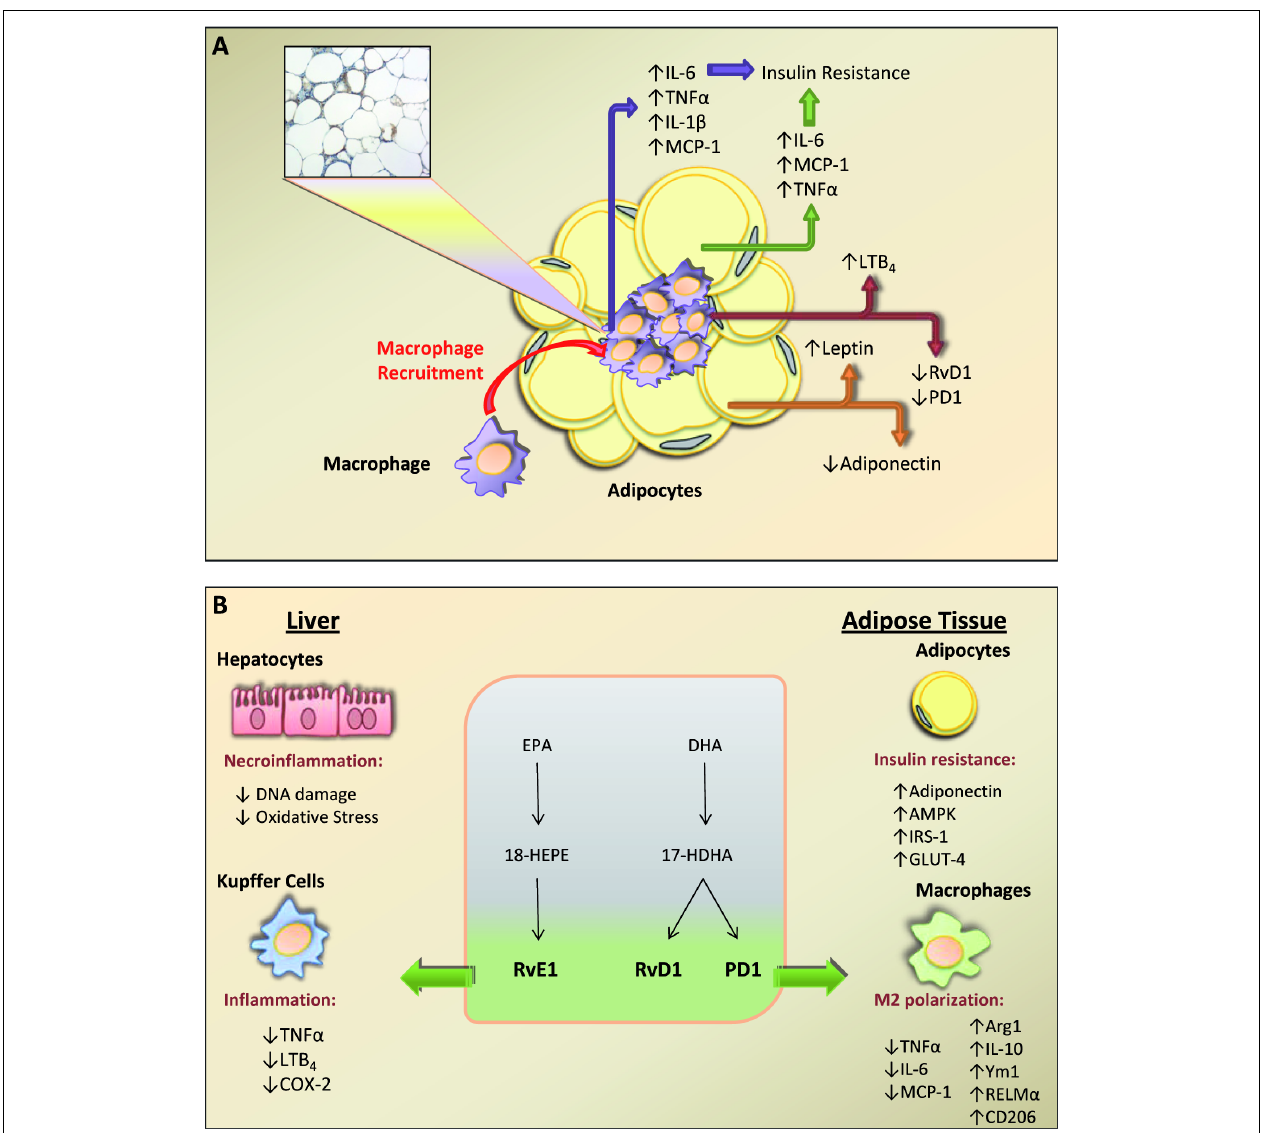
FIGURE 2 | (A) Schematic overview summarizing the cross-talk between macrophages and adipocytes in obese adipose tissue. Obese adipose tissue shows a remarkable infiltration of macrophages which form “crown-like” structures that surround necrotic adipocytes.This recruited macrophages together with hypertrophy and/or hyperplasia of adipocytes produce an aberrant release of pro-inflammatory adipokines [tumor necrosis factor (TNF) α , interleukin (IL)-6, IL-1 β , and monocyte chemotactic protein-1 (MCP-1)] that leads to insulin resistance. Unbalanced formation of pro-inflammatory leukotriene (LT) B 4 and leptin accompanied by a deficit in anti-inflammatory mediators [i.e., resolvin (Rv) D1, protectin (PD) 1, and adiponectin] contributes to a state of unresolved inflammation in obese adipose tissue. (B) Schematic representation of the protective actions of specialized omega-3-derived